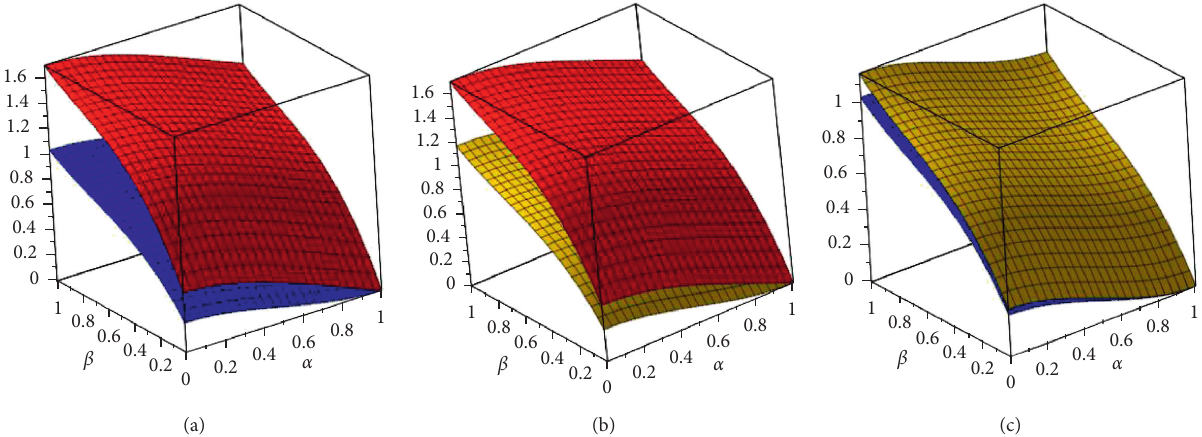
Figure 12: A functions of 􏽥 A and 􏽥 B , 􏽥 A and 􏽥 C , and 􏽥 B and 􏽥 C from Chutia and Saikia’s [25] α , β